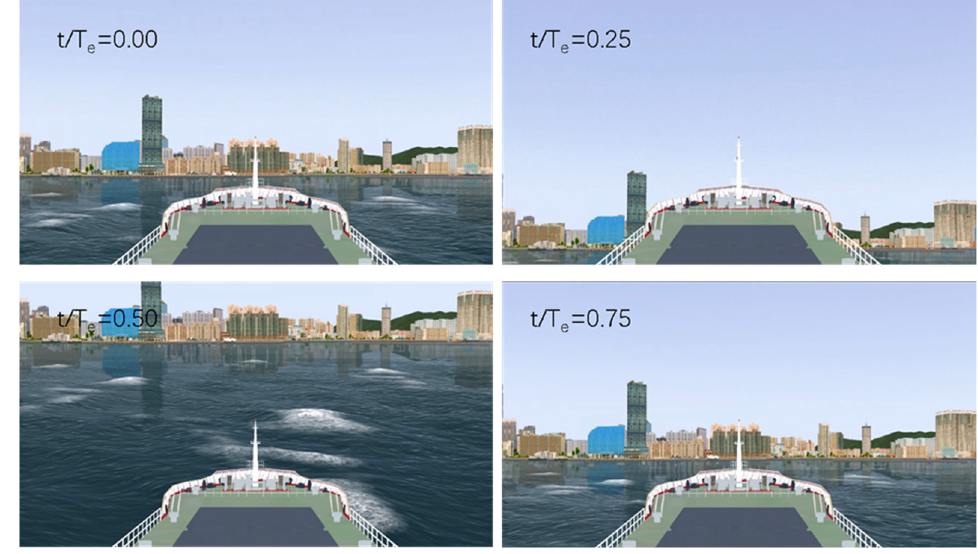
Figure 21. Visualized diagram of ship motion during a period of encounter of “Yukun” (Case CY9).